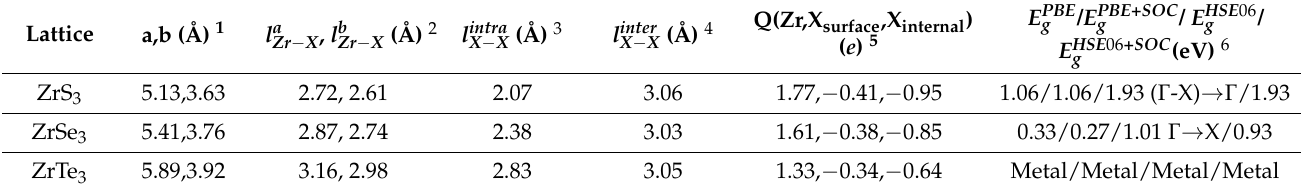
(Figure 1). 4 Distance between adjacent X 2 moieties. 5 Average Bader charges on each of the Zr atoms, X atoms of X 2 moieties (X surface ), and internal X atoms (X internal ), respectively (Figure 1). 6 Band gaps using PBE functional ( E PBE g )/PBE functional with inclusion of spin-orbit coupling (SOC) effect/ HSE06 functional ( E HSE 06 g )/HSE06